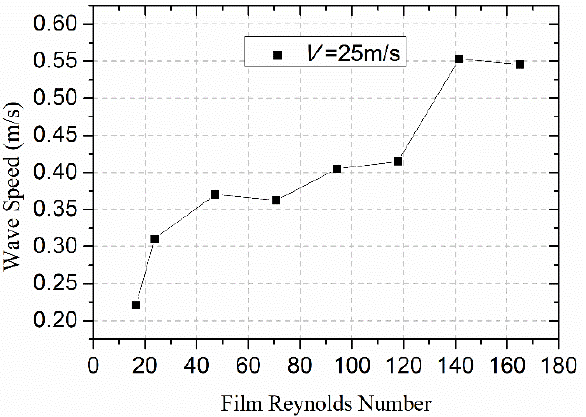
Figure 12. The variation in the Reynolds number and fluctuation velocity of the water film.